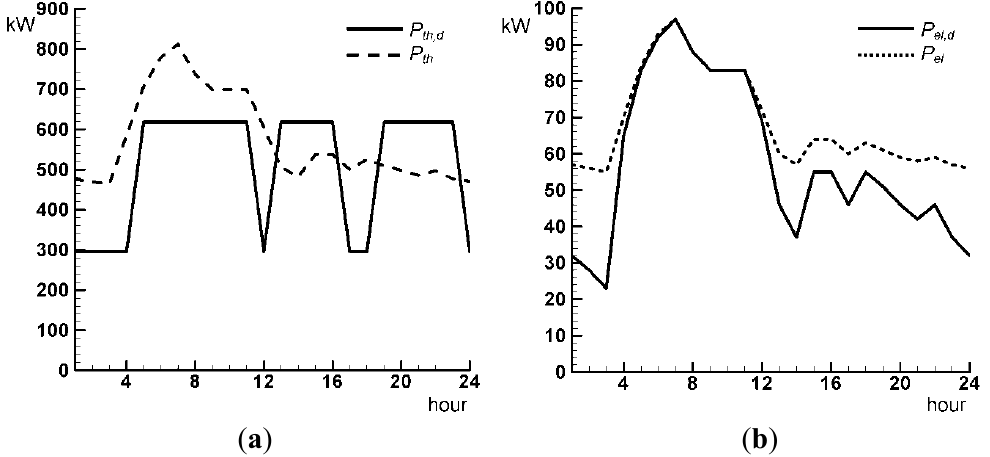
Figure 12. Thermal ( a ) and electric ( b ) behaviour with the electric load tracking matching for a typical winter